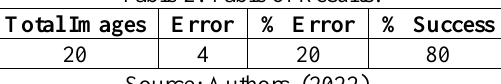
Table 2: Table of Results.